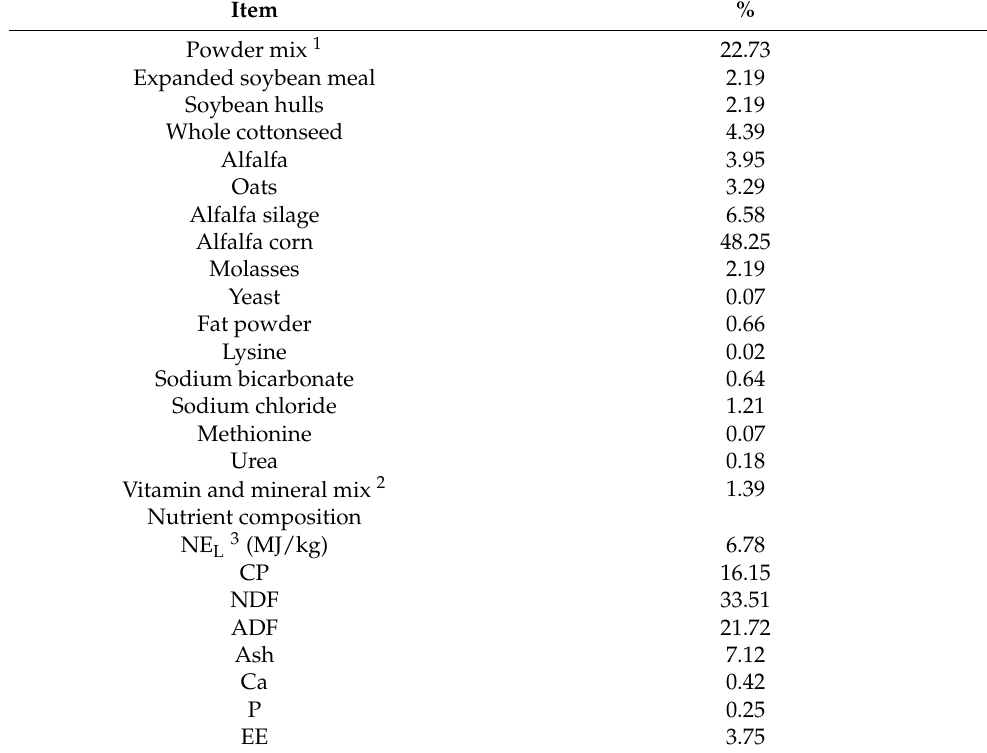
Table 1. Ingredients and nutrient composition of the experimental diet (% of